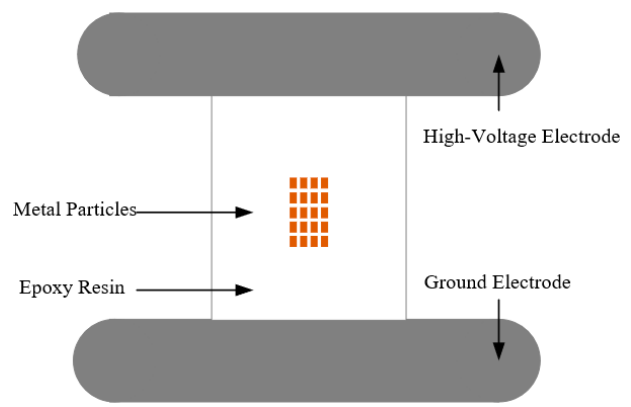
Figure 14. Metal contamination defects model on the insulator